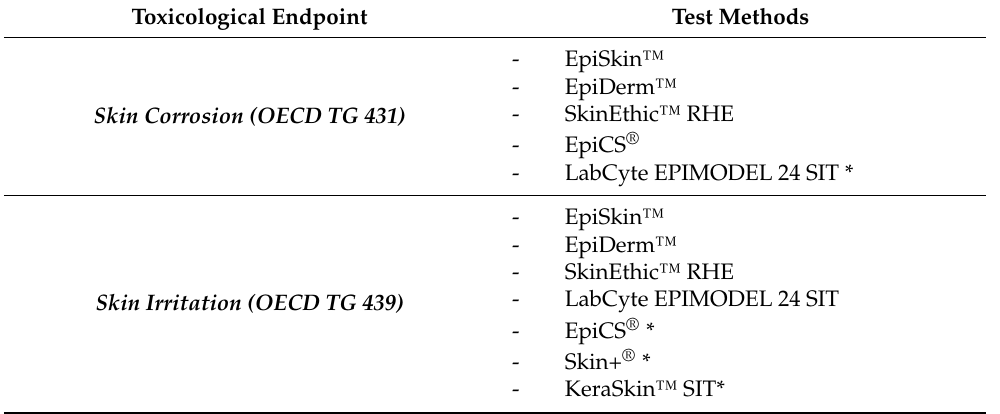
Figure 3. Bottom-Up and Top-Down in vitro testing strategy approach for irritation testing (modified from [94]). Table 4. Commercially available in vitro testing methods for skin irritation/corrosion, used to devise OECD TG 439 and 431. (*) methods are not included in the Commission Regulation (EU) 2019/1390